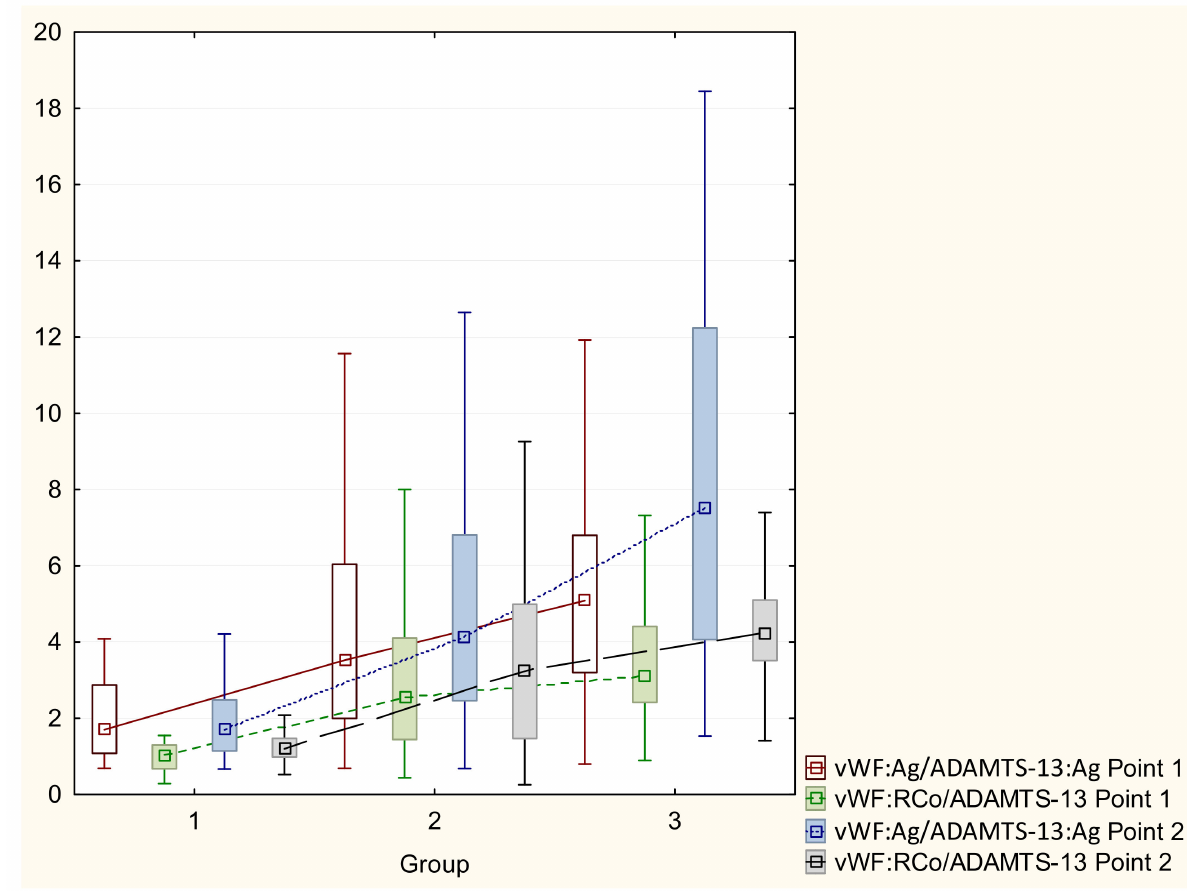
Figure 1. vWF/ADAMTS-13 ratio in patients with COVID-19.